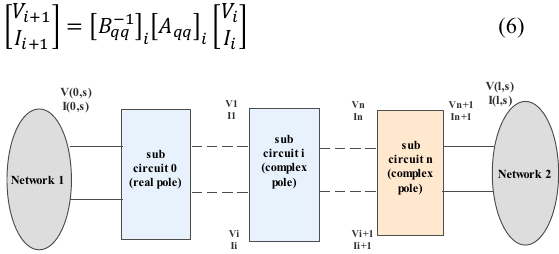
Fig. 2. Equivalent circuit of the line in the sense of Padé: represented by pole-zero section.